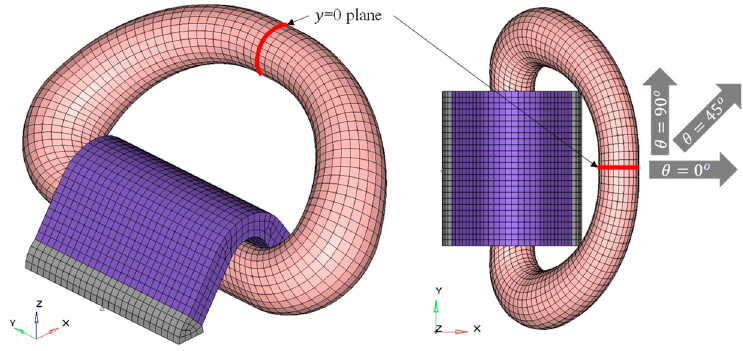
Figure 4. Mid-plane of the D-rings and in-plane angle 𝜃 .